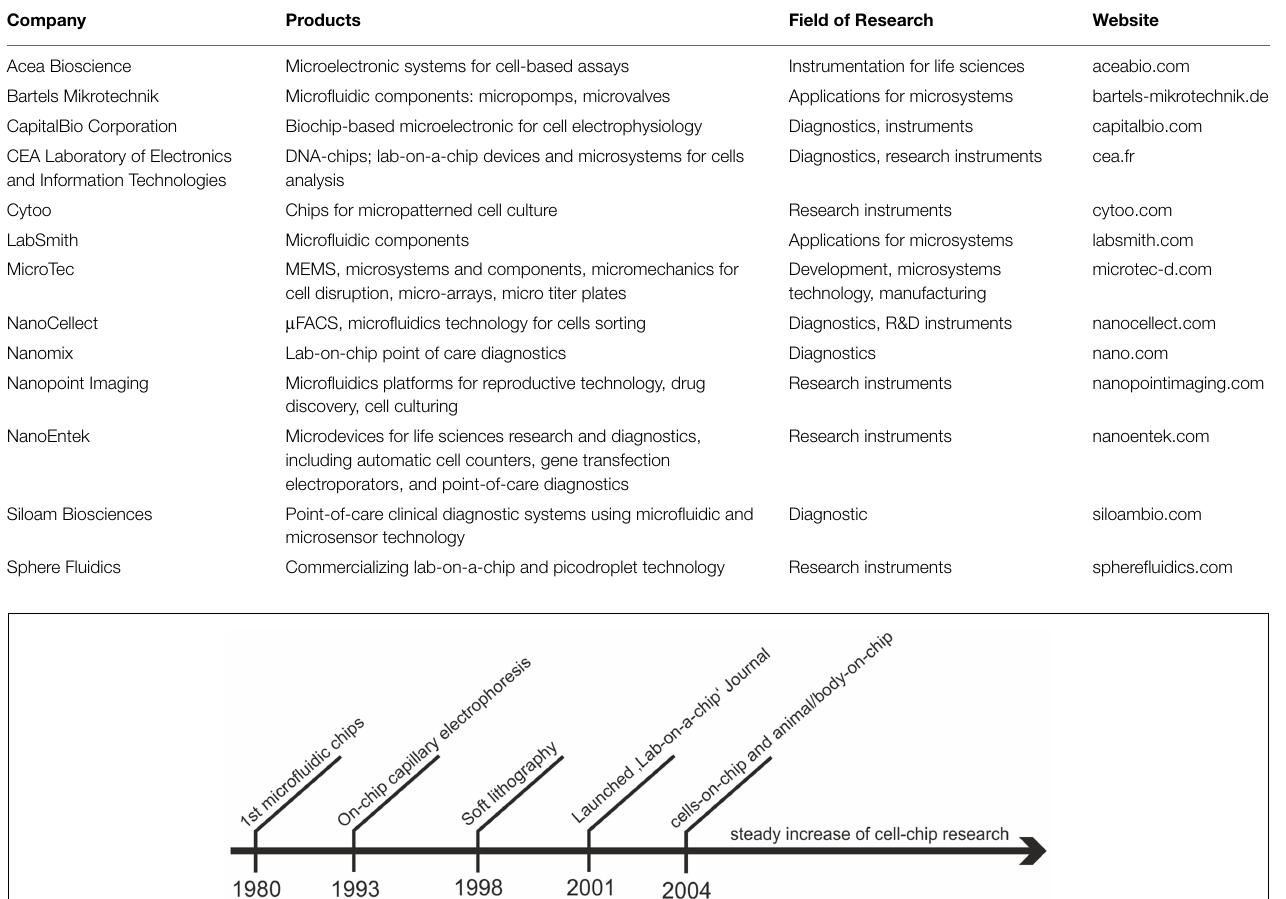
TABLE 3 | Companies offering miniaturized cell analysis systems .